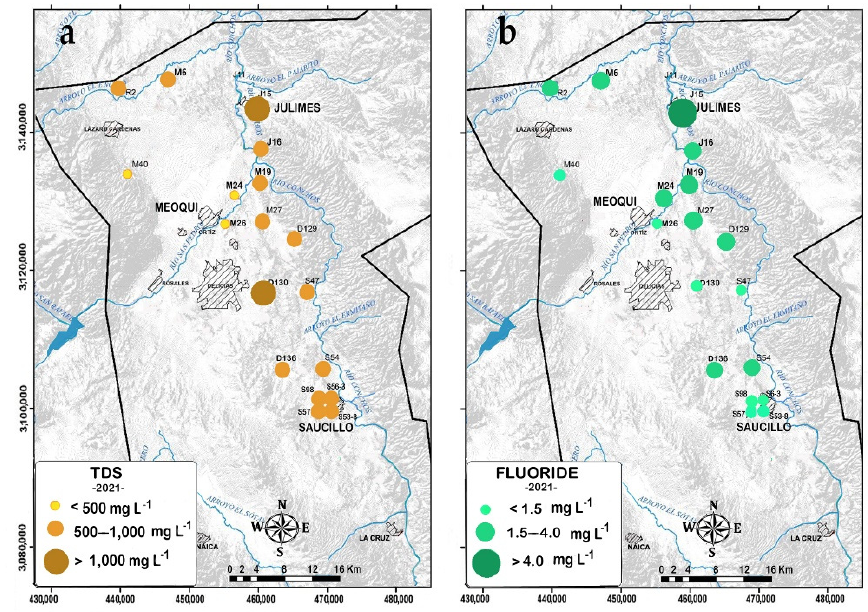
Figure 3. ( a ) Total dissolved solids (TDS) and ( b ) F − concentrations in the sampled wells. The Spearman correlation coefficient between F − concentrations and TDS was low (r = 0.24), and p , the probability of r being significant at 95% ( α = 0.05, two tailed), was not significant at p < 0.05. A visual comparison between the plotted concentrations (Figure 3) shows a roughly similar pattern, except for wells M24 and D130, whose difference in concentrations was high enough to lower the correlation coefficient below the 95% con- fidence threshold. In contrast, the correlation coefficient between F − concentration and well depth was − 0.52 and was significant at p < 0.05. As a way to validate the relationship between well depth and F − concentrations, and since the correlation was moderate and not a strong one, the 2021 data were plotted (Figure 4). The diagram clearly shows decreasing F − concentrations with increasing well depth, which means that the F − concentration is highest in shallower wells and, for the most part, coincides with discharge